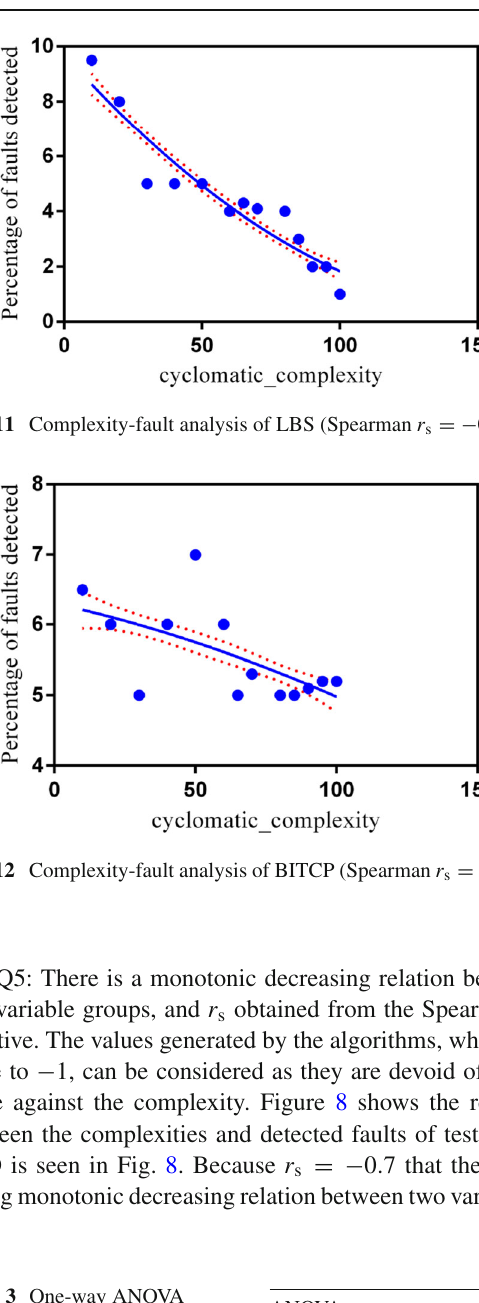
Table 3 One-way ANOVA results of APFD values produced by comparison algorithms